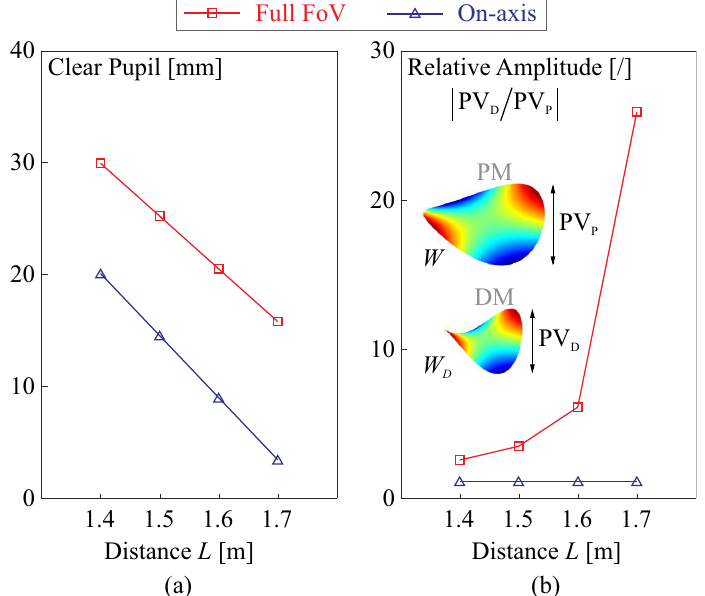
Figure 13. ( a ) Required pupil diameter and ( b ) forming amplitude (for Astigmatism Z5) with respect to L ; both on-axis and full FoV are considered, with a folding angle of θ = 20 ◦ .